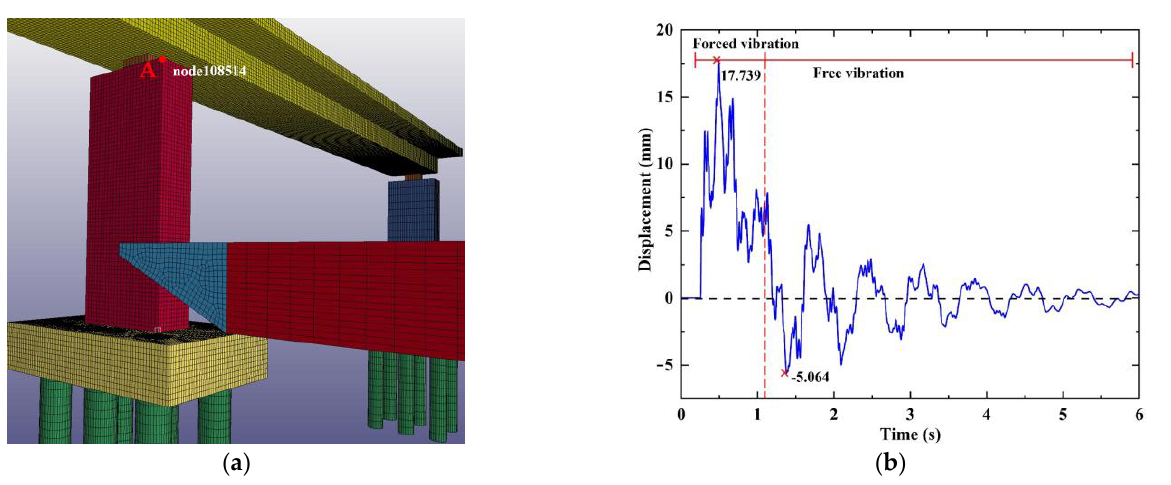
Figure 8. Collision-induced displacement from Point A (Node 108514) at the pier top: ( a ) the location of Point A (Node 108514); ( b ) the vibration-displacement curve of Point A.